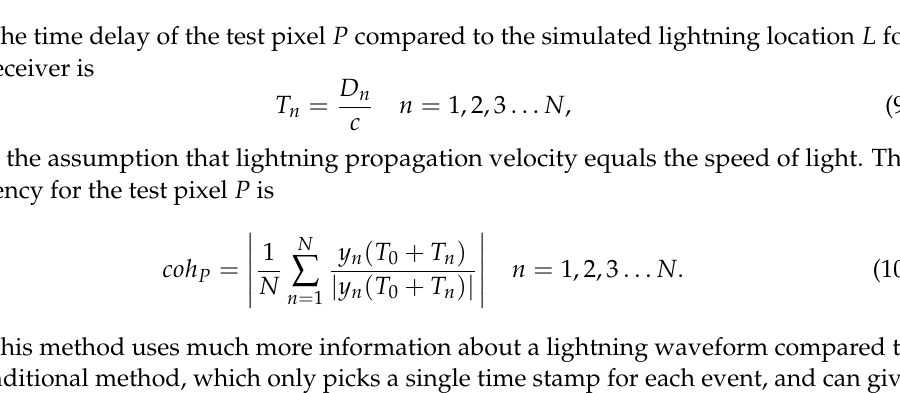
Figure 5. Amplitude waveforms from the amplitude waveform bank used to simulate the coherency